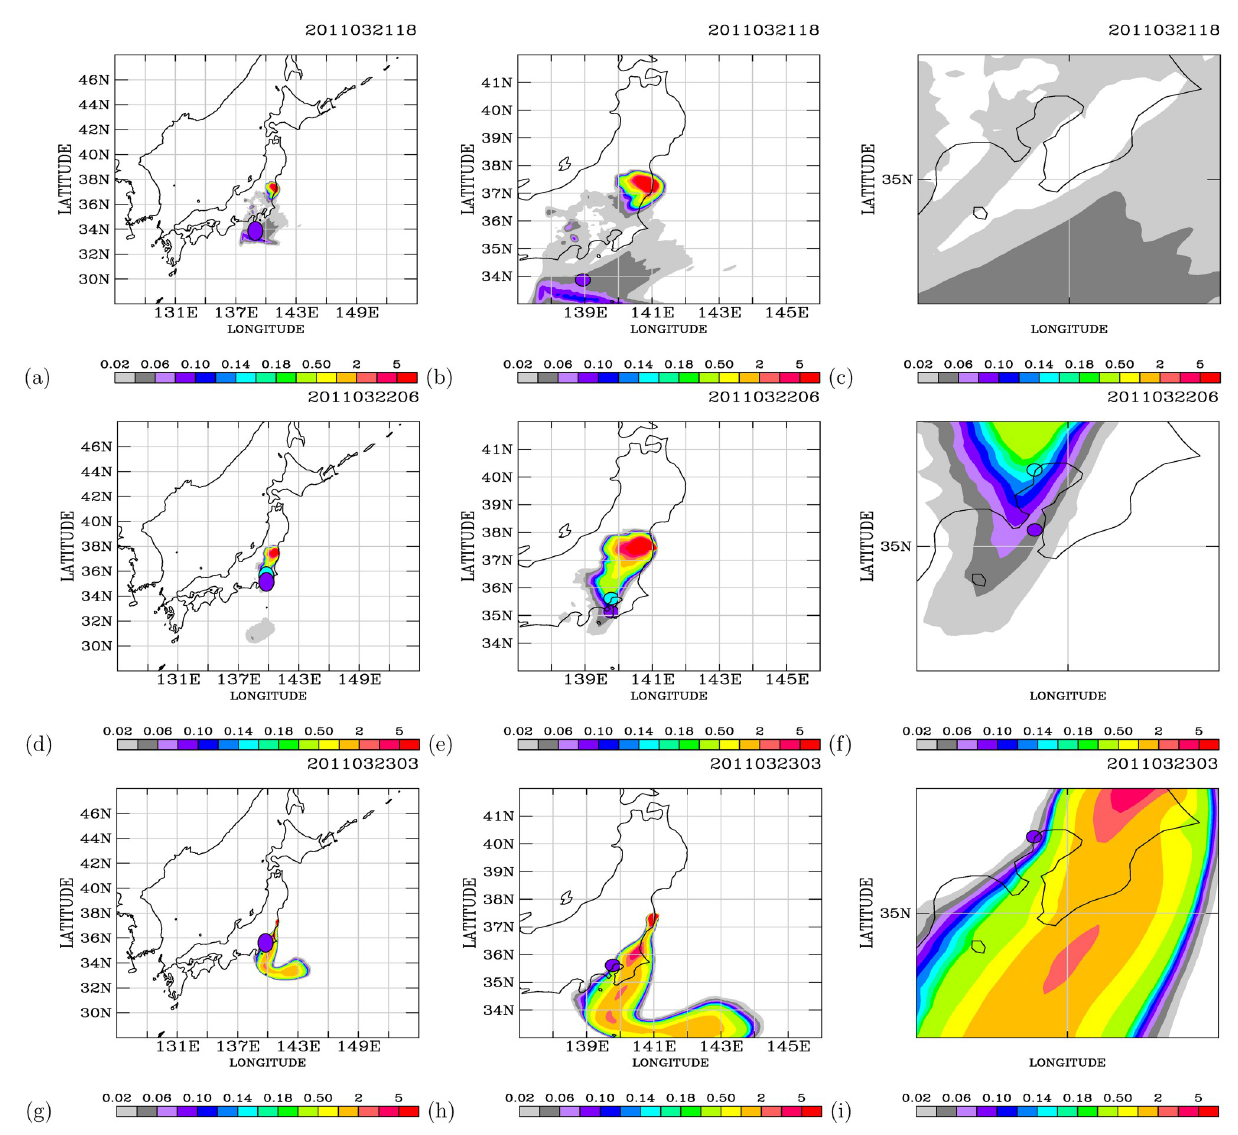
Fig 11. Comparison of the simulated and observed air dose rates on each day for 21–23 March 2011. Results presented in (a) large-scale, (b) magnified, and (c) Port of Tokyo area views for 18 UT on 21 March 2011. (d), (e) and (f) are the same but for 06 UT on 22 March, and (g), (h), and (i) are the same but for 03 UT on 23 March. The observed air dose rates at the corresponding times and locations are encircled with black curves. Map made with Natural Earth. Free vector and raster map data at